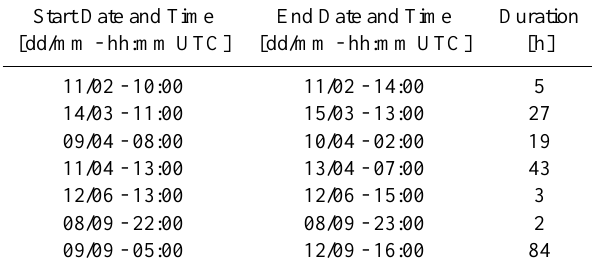
Table 2. Summary of data gaps in the buoy data set in the period running from 1 February to 31 December